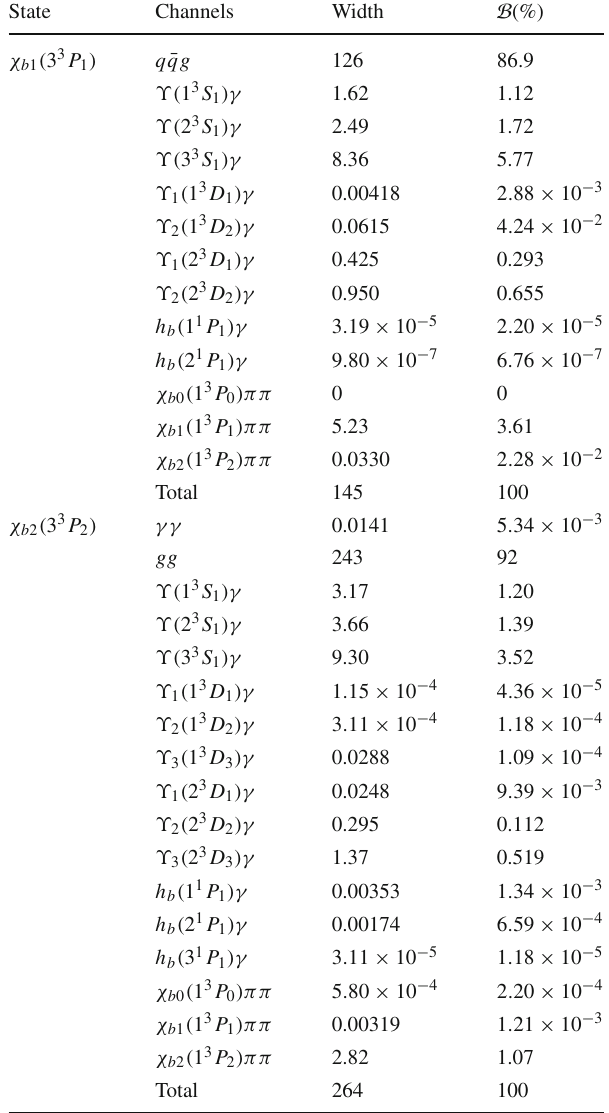
Table 9 Partial widths and branching ratios of annihilation decay, radiative transition, and hadronic transition and total widths for 3 3 P 1 and 3 3 P 2 bottomonium states. The width results are in units of